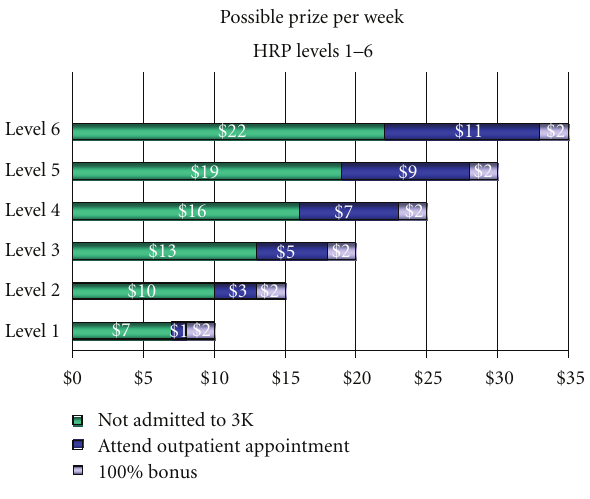
Figure 1: Payment